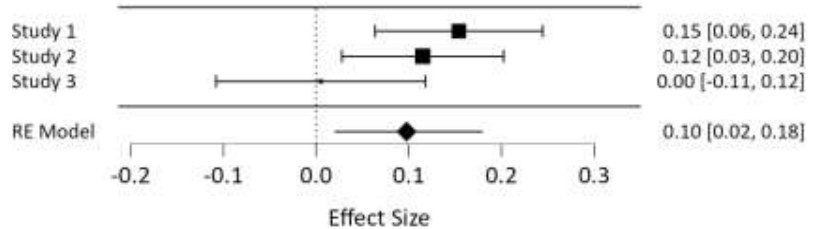
Figure 9. Forest plot of meta-analysis of Motivation for knowledge and Extraversion